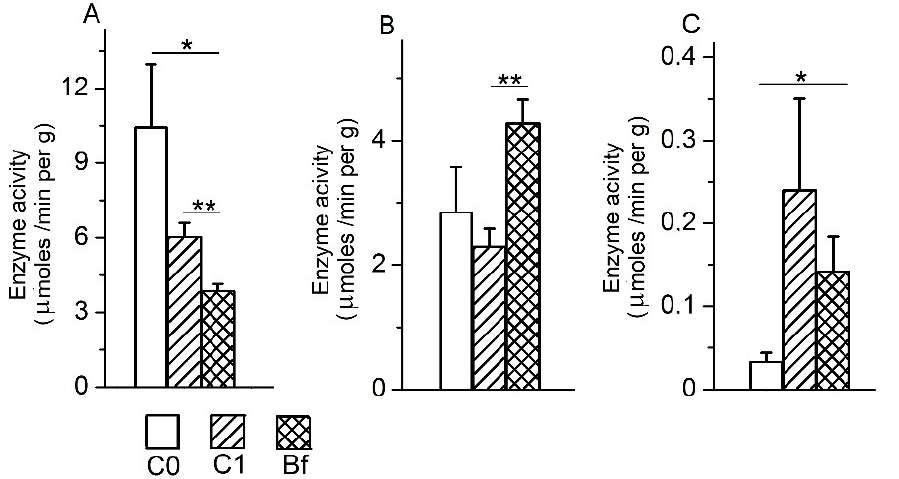
Figure 8. Effects of indigenous bifidobacteria on the specific activities of maltase ( A ), alkaline phosphatase ( B ), and aminopeptidase N ( C ) in the chyme of different parts of the intestine in a rat model of antibiotic-associated dysbiosis. ( A – C ) The rat groups: C0 (control)—without the introduction of antibiotics and autoprobiotic, C1—without the introduction of autoprobiotic after the withdrawal of antibiotics, and Bf—with the introduction of indigenous bifidobacteria after the withdrawal of antibiotics. ( A ) Student’s t -test, * p < 0.05, ** p < 0.01. ( B ) Student’s t -test * p < 0.01. ( C ) Students t -test, * p < 0.02, ** p < 0.05.